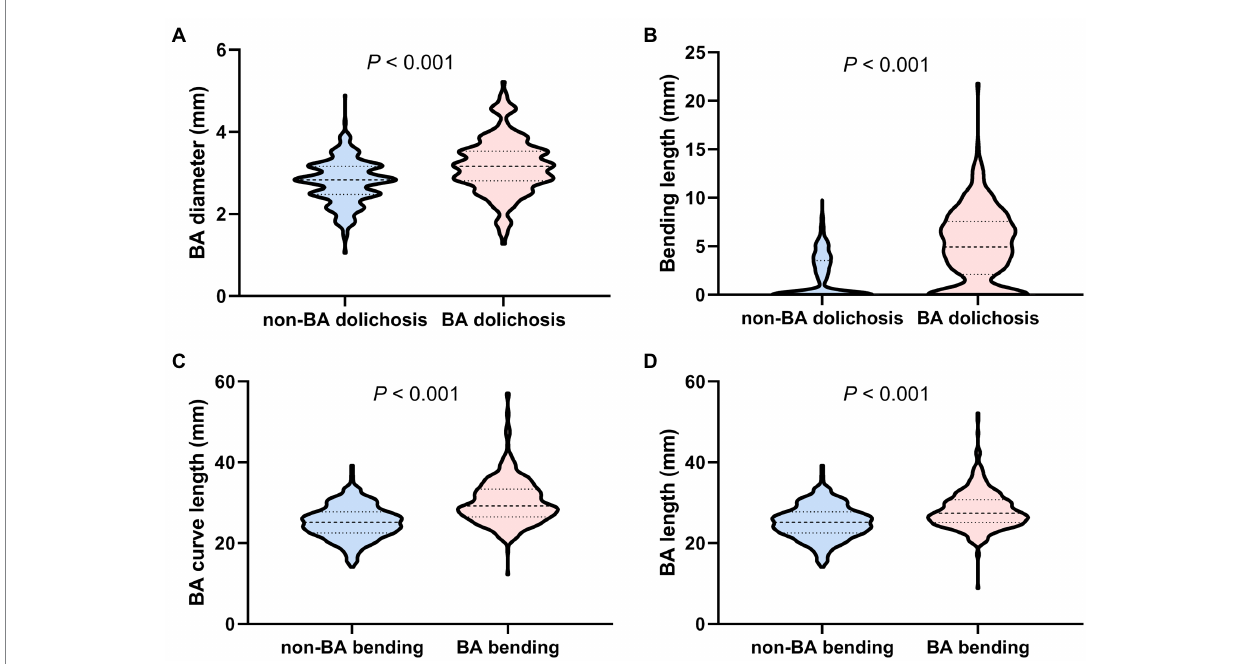
FIGURE 2 Comparison of BA diameter and BL between patients with BA dolichosis and non-BA dolichosis (A,B) ; Comparison of BA curve length and BAL between patients with BA bending and non-BA bending (C,D)